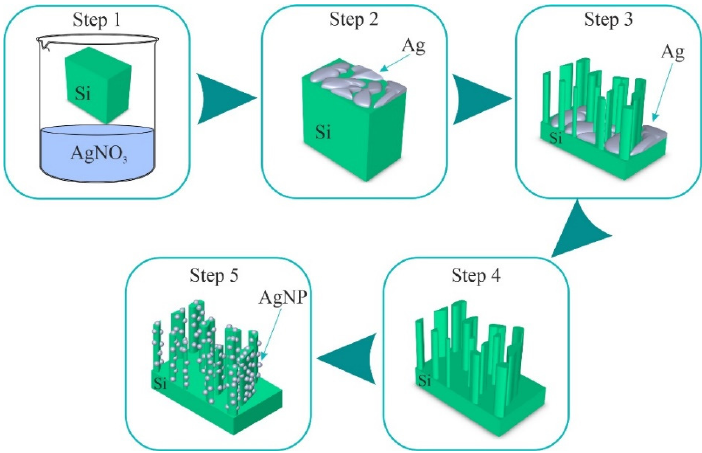
Figure 1. Schematic representation of the stages for obtaining a composite structure of Ag/SiNWs.